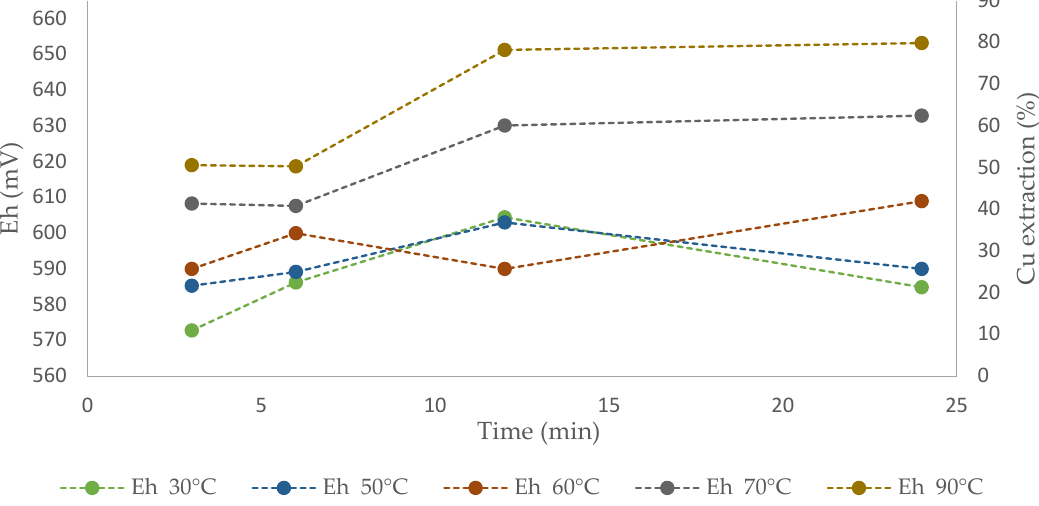
Figure 9. E ff ect of potential Cu extraction from CuFeS 2 using ionic liquid at 20% ( v / v ) and 100 g / L of Figure 9. Effect of potential Cu extraction from CuFeS 2 using ionic liquid at 20% ( v/v ) and 100 g/L of Br − at temperatures of 30, 50, 60, 70, and 90 ◦ Br − at temperatures of 30, 50, 60, 70, and 90 °C.